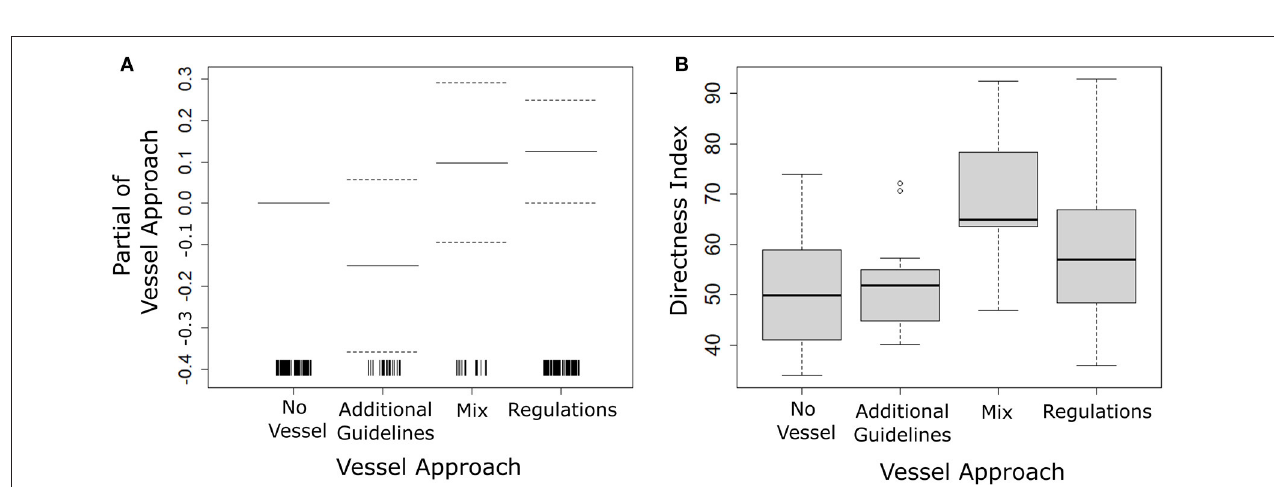
FIGURE 11 | Results from the best fit generalized additive model (GAM) for humpback whale path directness showing (A) model parameter estimates for vessel approach type (No Vessel: no vessels within 500m; Additional Guidelines: vessels(s) were approaching under additional voluntary guidelines; Regulations: vessel(s) were assumed approaching under federal regulations only; Mix: multiple vessels approaching with one or more following additional voluntary guidelines and one or more following federal guidelines only) and (B) model predicted path directness based upon vessel approach type. Dashed lines in image (A) represent the 95% confidence intervals of the parameter estimate and vertical ticks indicate the locations of observations (i.e., a